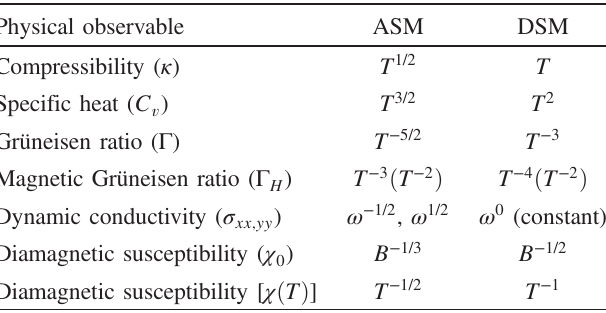
TABLE I. Power-law scaling of various physical observables for the anisotropic semimetal (ASM) and Dirac semimetal (DSM). The Grüneisen ratio is defined as Γ ¼ α / C , where α P is the thermal expansion parameter and C is the specific heat, P measured at constant pressure. The magnetic Grüneisen ratio is ∂ M / ∂ T Þ defined as Γ / C , where M ∝ H is the magneti- H ¼ ð H H zation, C is the molar specific heat, and H is the magnetic field H strength. When the Zeeman coupling dominates over the orbital one, Γ has the same power-law dependence in the ASM and H DSM (shown inside the parentheses in the fourth row). By contrast, when orbital coupling of the magnetic field dominates over Zeeman coupling, Γ has distinct scaling behaviors in the H ASM and DSM (displayed outside the parentheses in the fourth row). The explicit form of the dynamic optical conductivity ( σ ) jj and diamagnetic susceptibility ( χ 0 ) in the ASM are, respectively, shown in Eqs. (3) and (4). The scaling of the diamagnetic susceptibility at finite temperature and low magnetic field (no Landau quantization) is shown in the last row. The crossover behavior between the ASM and the DSM at finite temperature, frequency, and magnetic field is discussed in the text. All physical observables display activated behavior in the band